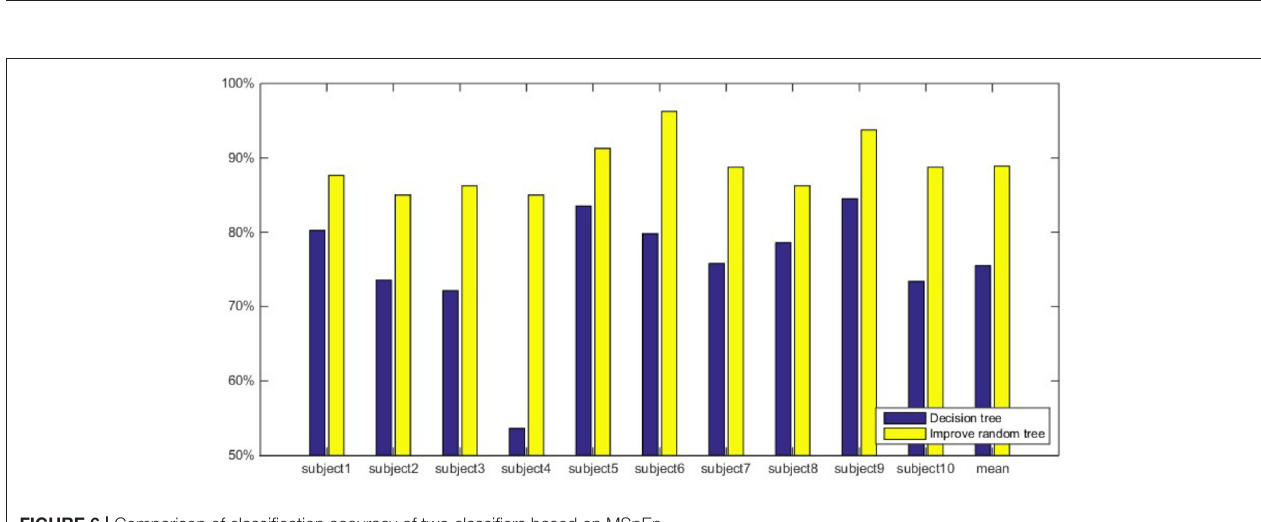
FIGURE 5 | Comparison of classification accuracy with three features and improved fandom forest.